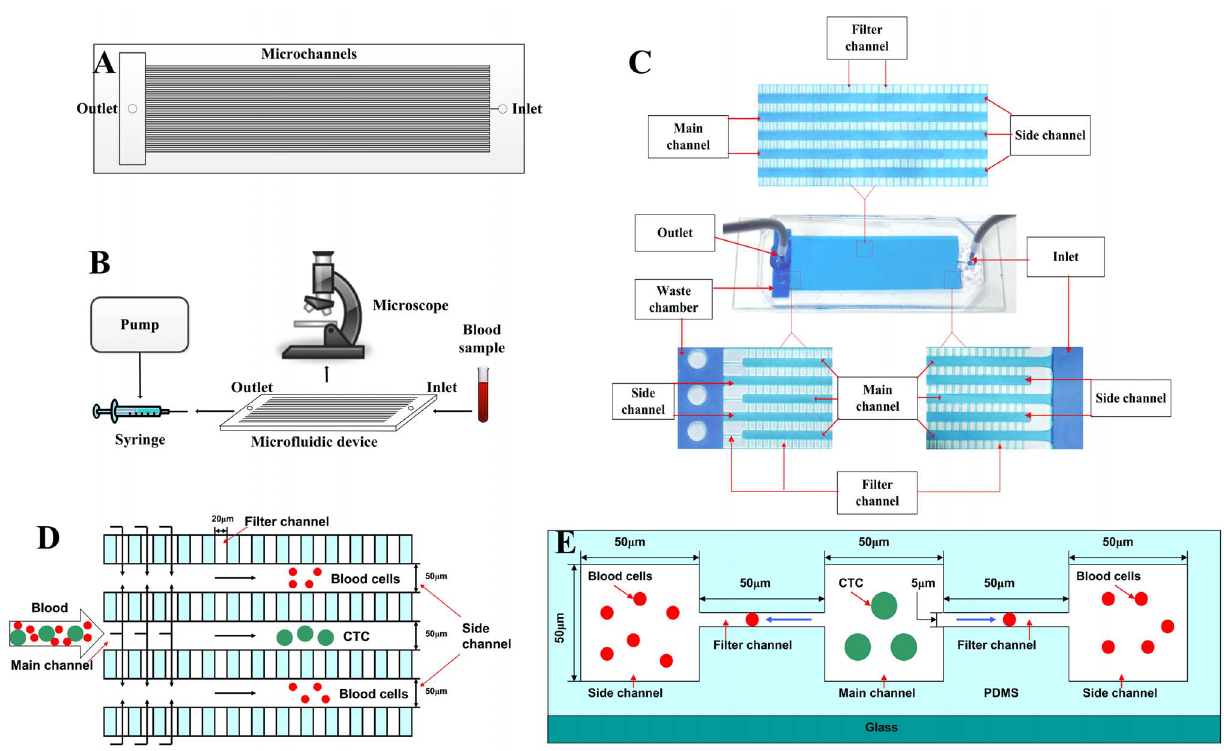
Figure 1. The theory and structure of the microdevice. A) The schematic of the microfluidic device; B) The schematic of workstation setup for CTC isolation; C) The structure of the device under the microscope; D) The schematic showing the theory of the device in vertical view; E) The schematic showing the theory of the device in profile view.